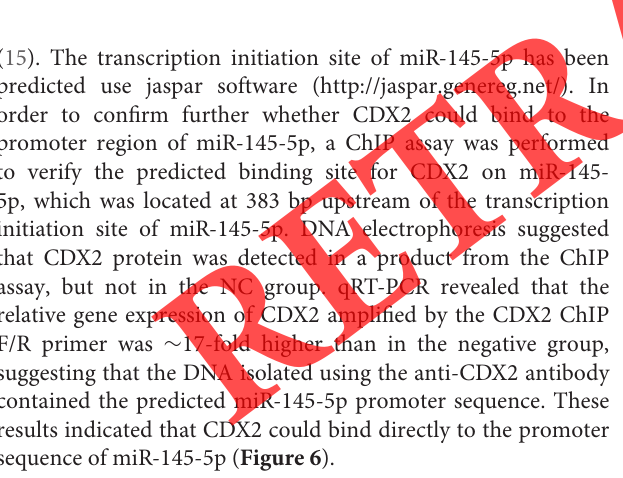
FIGURE 4 | miR-145-5p binds directly to the 3 ′ UTR of SENP1. (A) The target sequences for miR-145-5p within the 3 ′ UTR of SENP1. (B) Comparison of luciferase activity in cells of different groups that were co-transfected with the 3 ′ UTR of SENP1. * P < 0.05. (C) Luciferase activity in cells of different groups that were co-transfected with mut-3 ′ UTR of SENP1. * P >